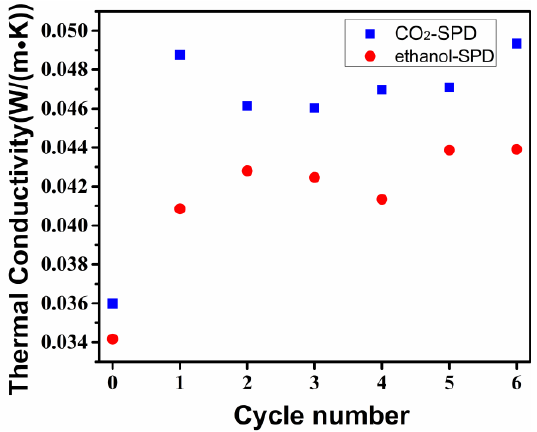
Figure 2. Thermal conductivity evolution of the CO 2 -SPD and ethanol-SPD aerogels via thermal shocks.